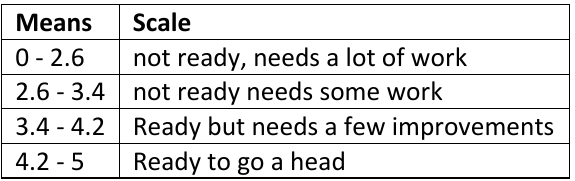
Table 1: The Scale and Indication of Means Means Scale 0 ‐